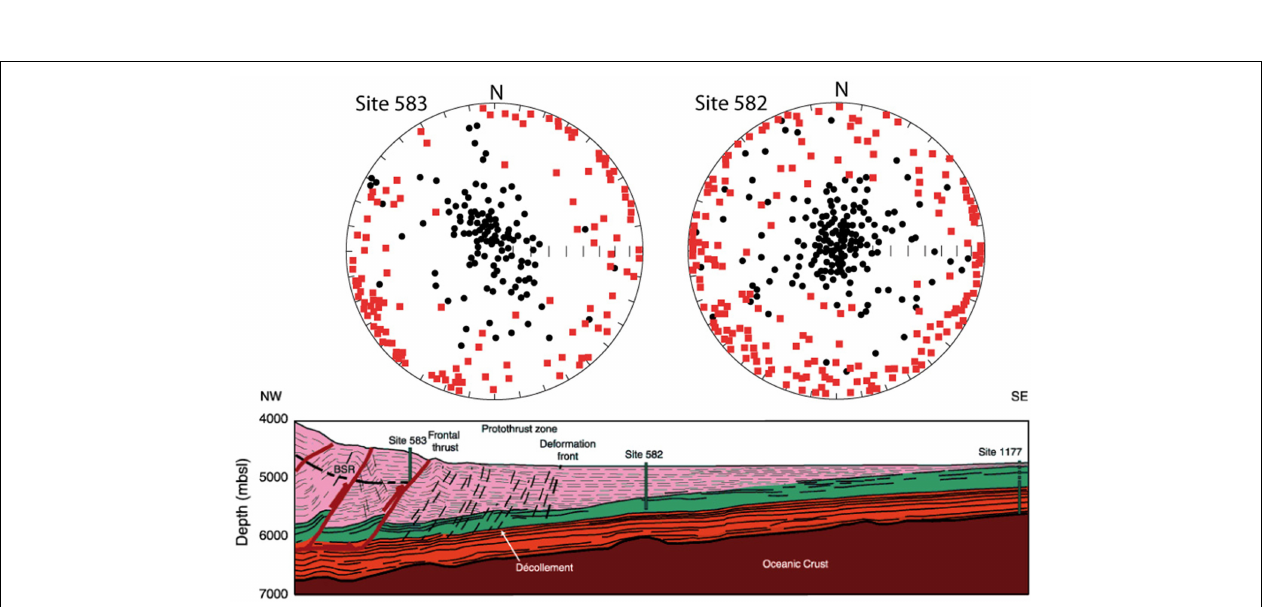
tectonic setting of the region; IBT, Izu-Bonin Trench; KPR, Kyushu-Palau Ridge; FSC, fossil spreading center; PSP, Philippine Sea plate (Moore et al., 2009).